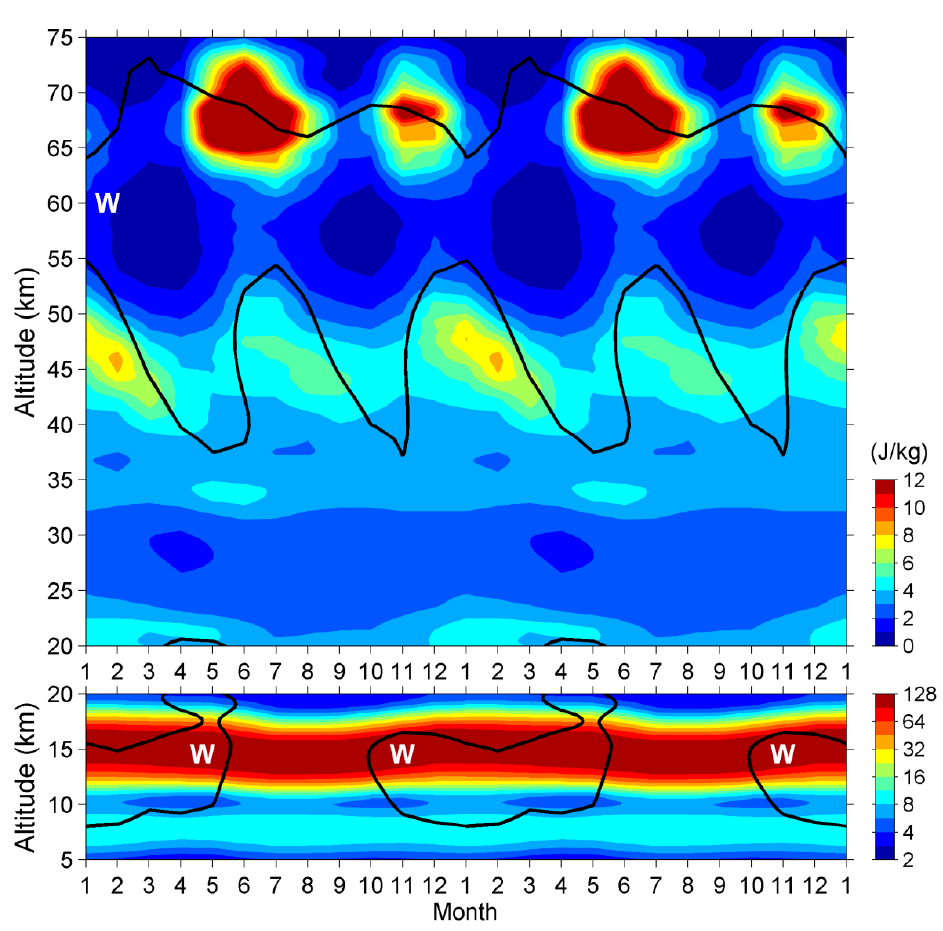
Figure 5. Same as in Figure 4 but showing the zonal mean E P of each month. 430